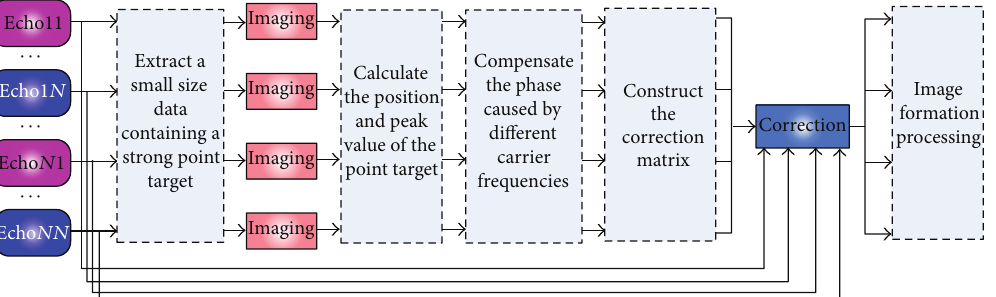
Figure 6: Block diagram of the channel imbalance correction.